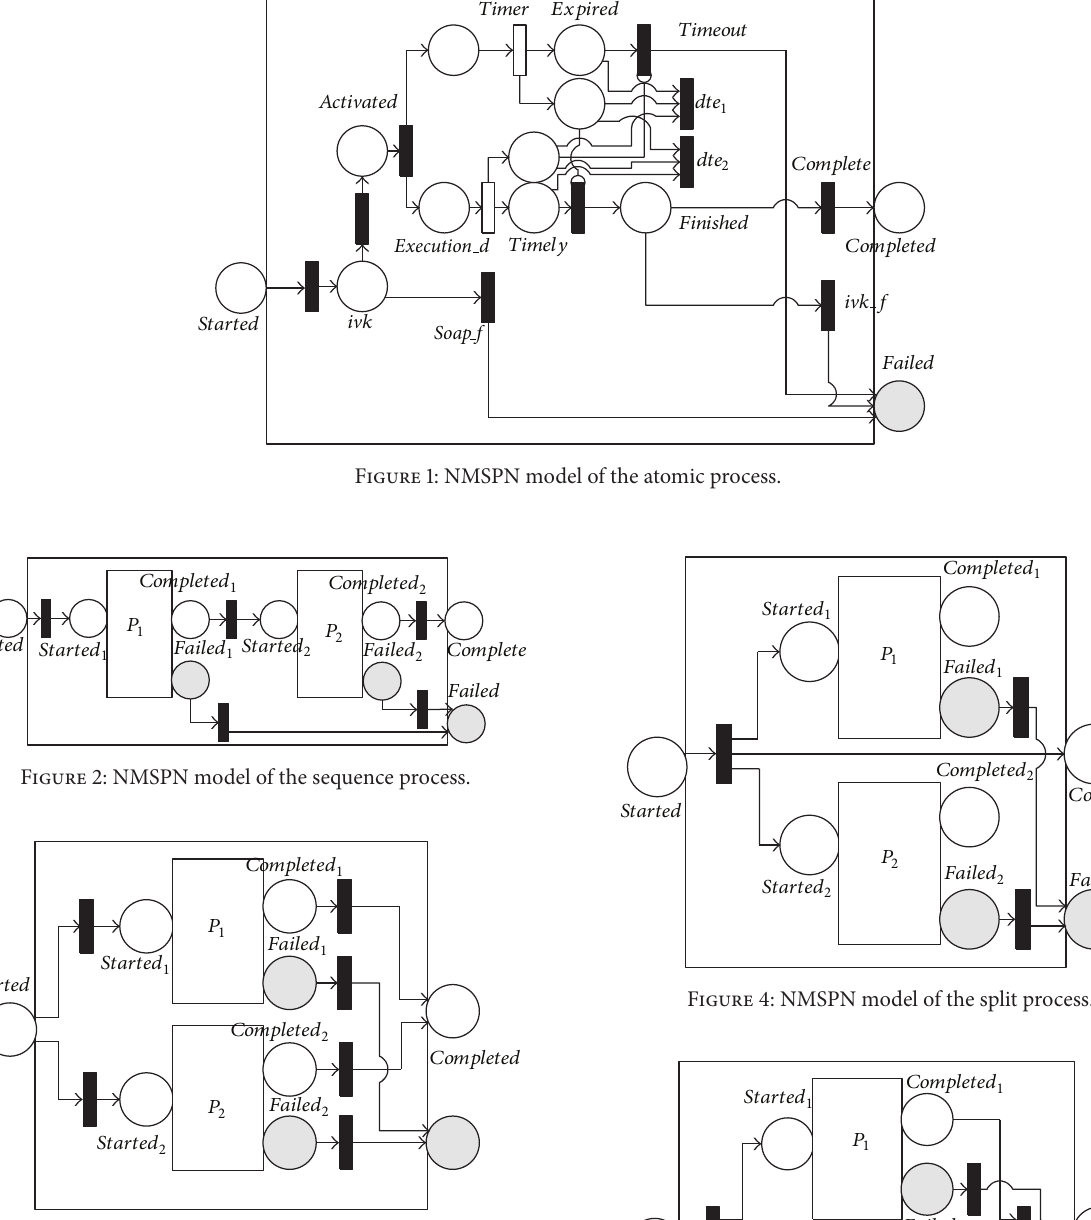
Figure 3: NMSPN model of the choice process.